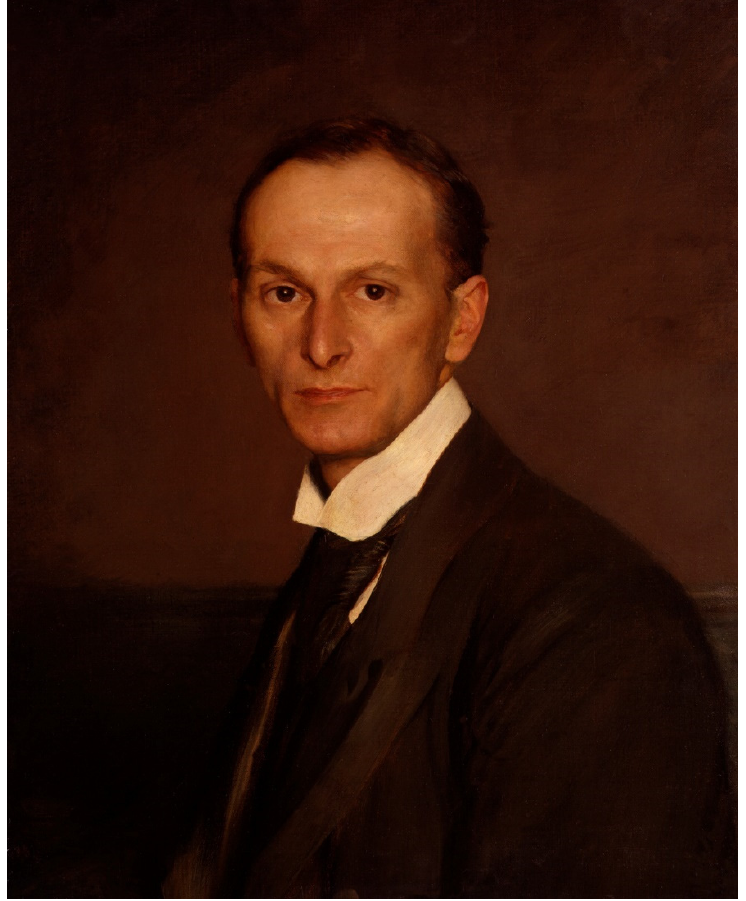
Figure 5. John Henry Frederick Bacon, Marion Harry Spielmann , 1904, oil on canvas. 24 in. × 20 in. (610 mm × 508 mm) . Image ID: 4352. © National Portrait Gallery, London.